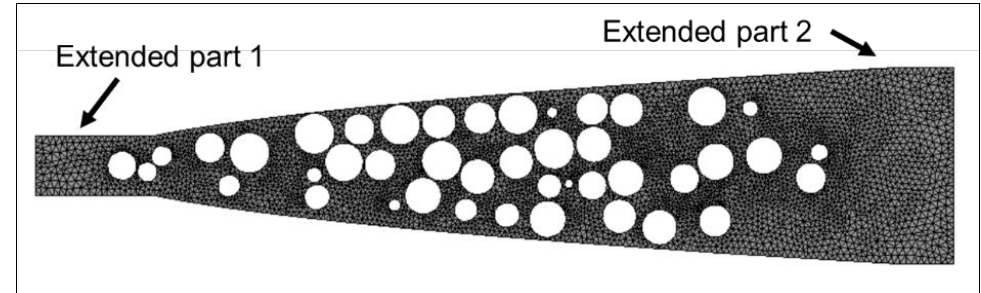
Figure 13. Numerical mesh of CFD analysis.